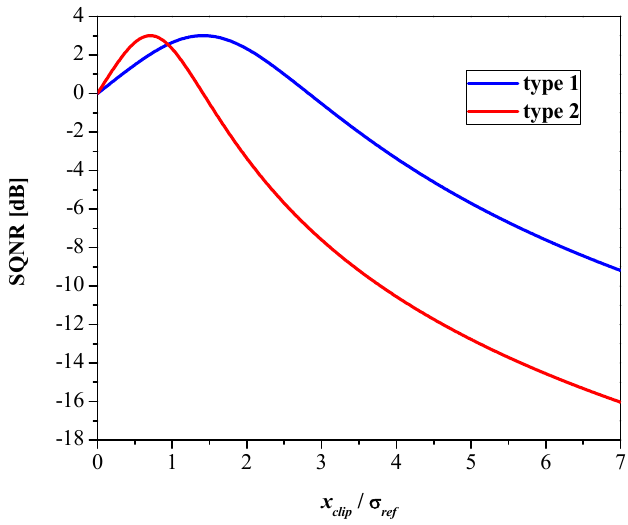
Figure 5. Performance evaluation of binary quantizers type 1 and 2 for a given x clip .